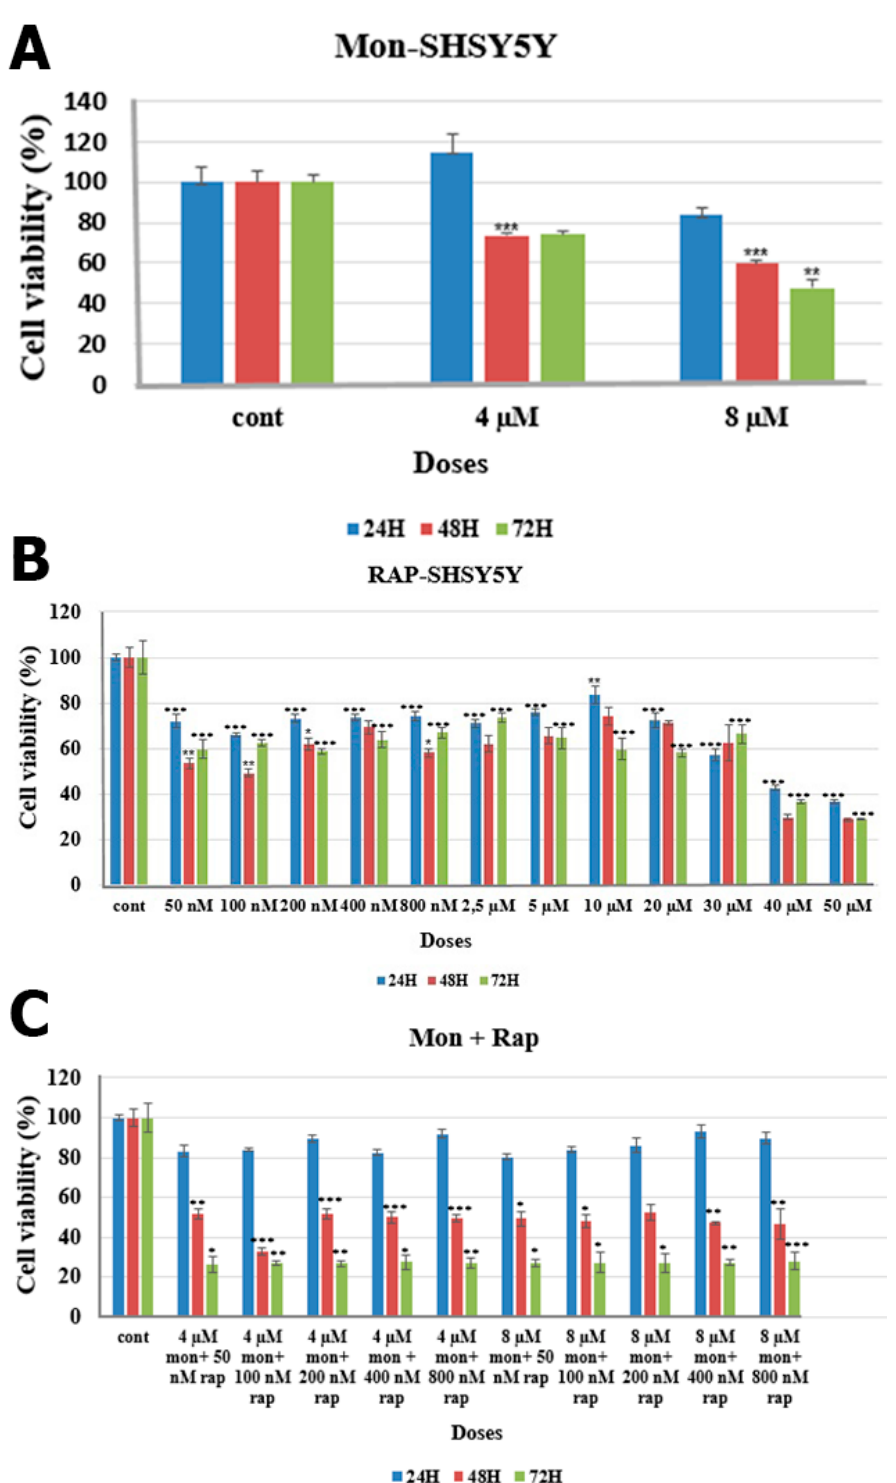
Figure 2. Effects of mon alone, rap alone, and combination of mon + rap on SH-SY5Y cell viability. ( A ) Effects of mon on cell viability. ( B ) Effects of rap on cell viability. ( C ) Effects of the combination of mon and rap on cell viability. Data are presented as mean ± SD. n = 3. *, **, and *** indicate statistical differences of p < 0.05, p < 0.01, and p < 0.001, respectively, compared to control group cells. The combination of mon and rap showed a substantial synergistic effect on SH-SY5Y cells at 72 h and low concentrations (CI < 1) (Table 1). For this reason, 72 h and the lowest concentration values were preferred in other experimental stages (50 nM rap + 4 µM mon).